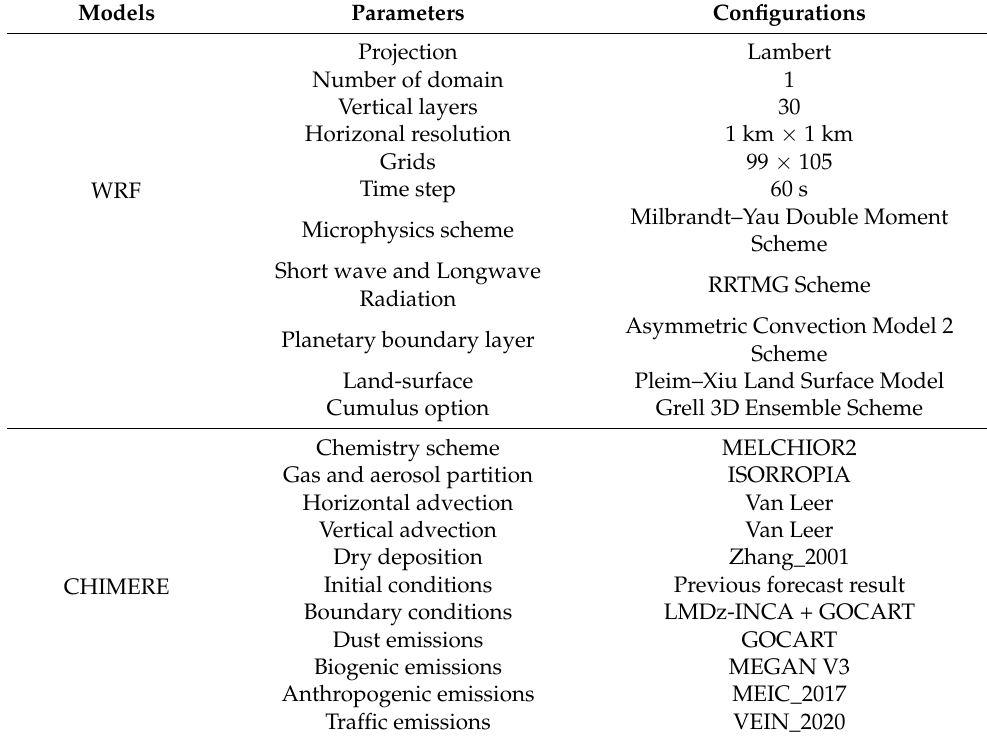
Table 1. Model configurations of WRF-VEIN-CHIMERE forecast